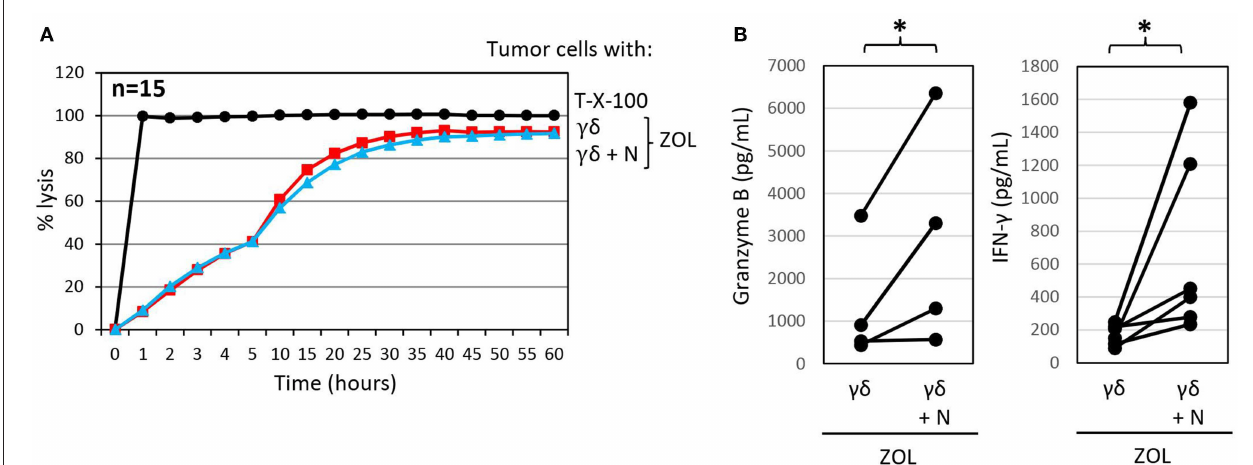
FIGURE 4 | Zoledronic acid pre-treated autologous neutrophils do not influence γδ T-cell mediated cytotoxicity but further enhance granzyme B and IFN- γ release. (A) Cytotoxicity of 125 × 10 3 γδ T cells alone or 250 × 10 3 neutrophils in combination with 125 × 10 3 γδ T cells ( γδ + N, E/T 25:1, blue line) toward Panc89 cells was measured by RTCA. Tumor cells and neutrophils were pretreated with ZOL (2.5 µ M) 3h before addition of γδ T cells. Percentage lysis was analyzed from RTCA data by calculating the normalized impedance of spontaneous lysis (cell growth of tumor cells in medium alone) in relation to the maximal lysis induced by 1% Triton-X-100 (T-X-100, black line) at indicated time points. The mean of 15 individual samples for the indicated time points are shown. (B) Granzyme B and IFN- γ release was measured after 24h by ELISA from supernatants generated under the same conditions as the RTCA experiments. The mean of four to six individual samples for the indicated time points are shown. Statistical analysis was performed by t -test. Significances are presented as P -Value; * P <